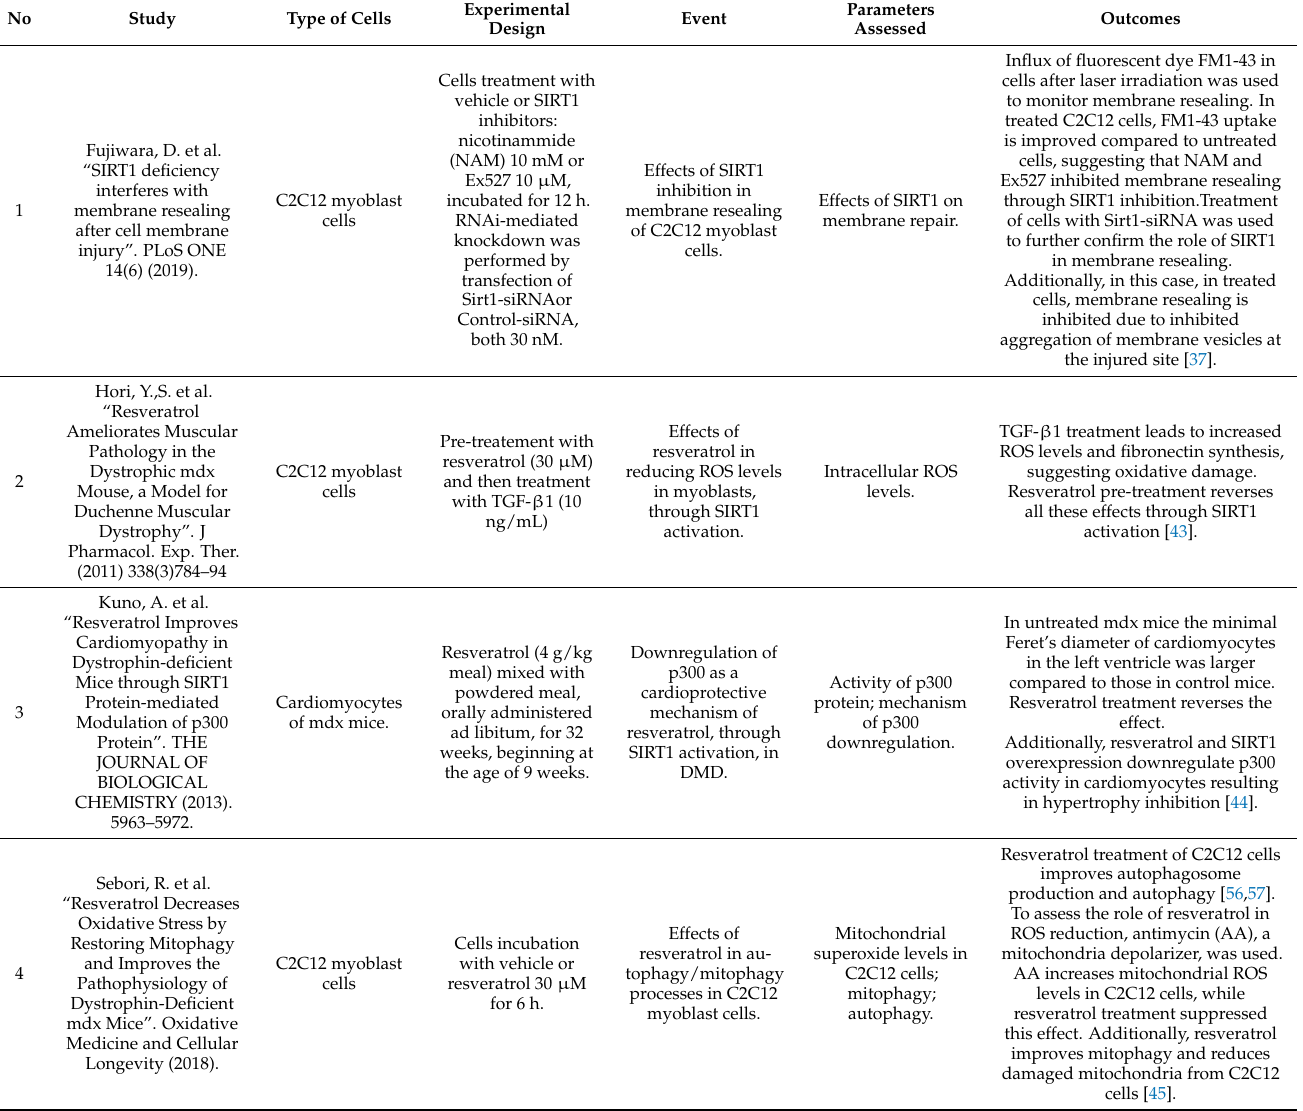
Table 2. Overview of the characteristics of in vitro animal and human studies included in the systematic